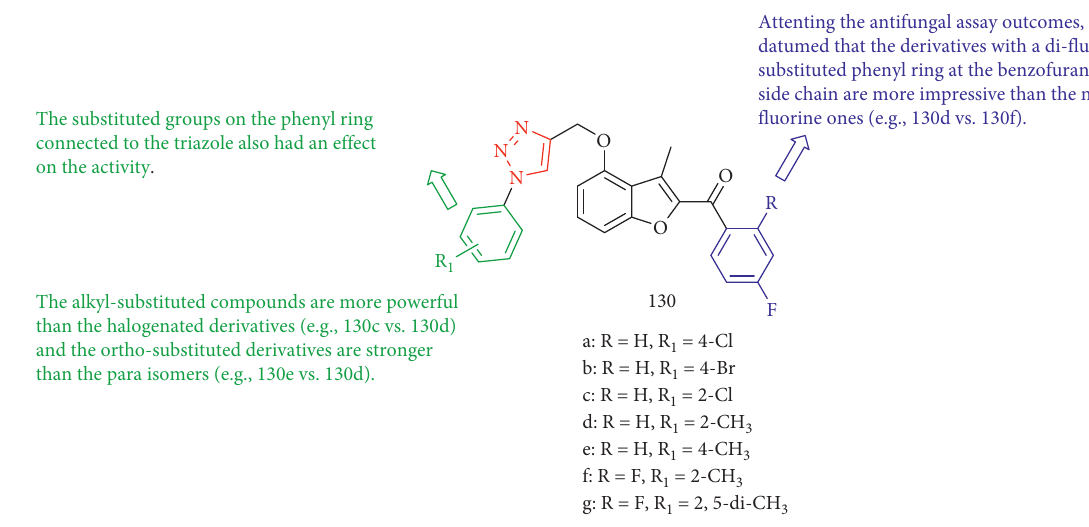
Figure 65: Chemical structure of novel benzofuran-triazole hybrids.